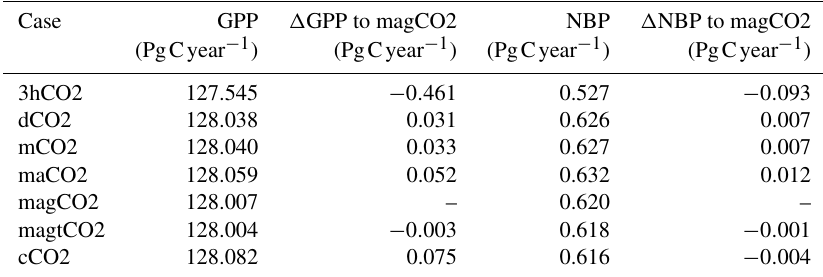
Table 2. Differences in mean global GPP and NBP compared to the case that uses the most popular atmospheric CO 2 forcing (magCO2). The values are the global mean of